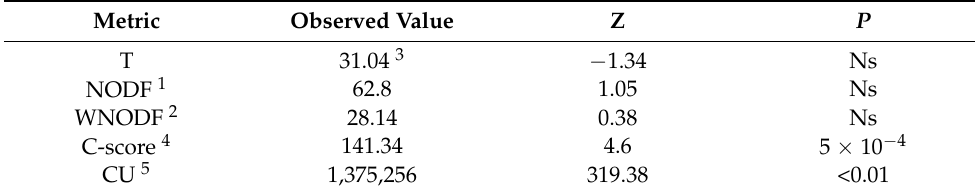
Table 2. Metrics used in nestedness and co-occurrence